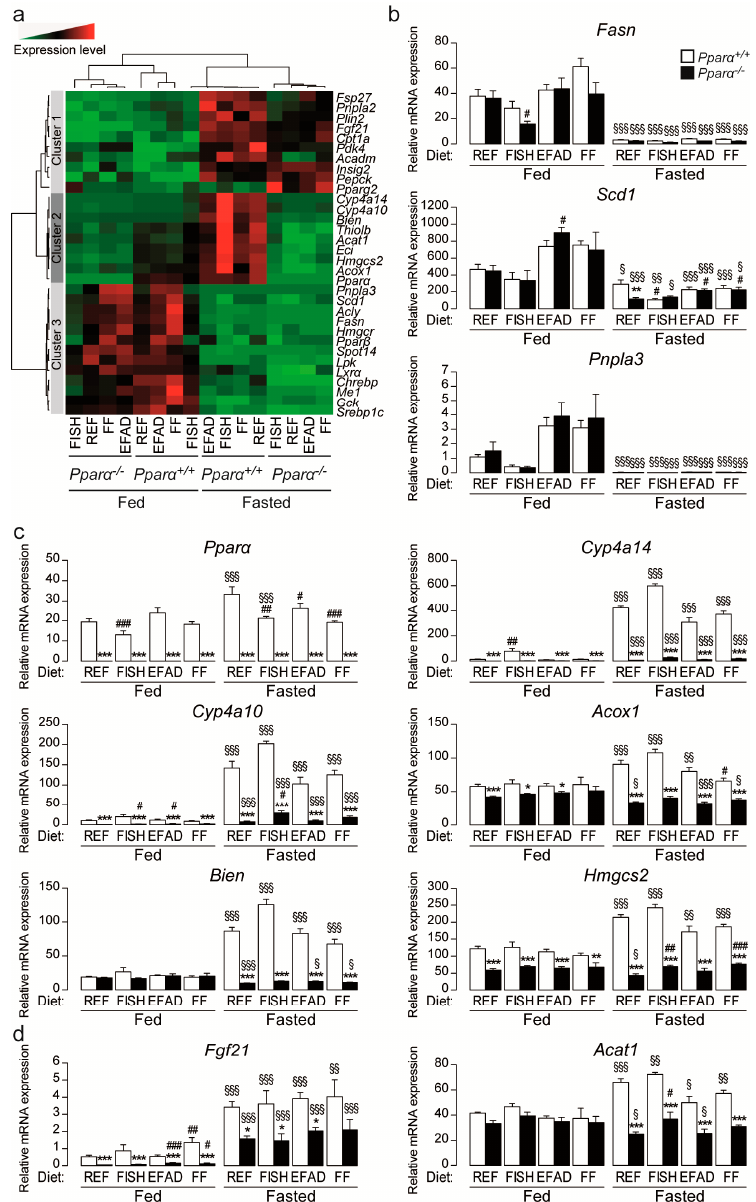
Figure 4. Effect of dietary fat on hepatic gene expression. Wild-type ( Ppar α +/+ ) and total Ppar α knockout ( Ppar α − / − ) mice were fed ad libitum or fasted for 24 h and then euthanized at ZT14. ( a ) Hierarchical clustering of hepatic gene expression data determined for 32 genes related to lipid metabolism and nuclear receptor signalling via qRT-PCR of liver samples from male Ppar α +/+ and Ppar α − / − mice; ( b – d ) Quantification of Fasn , Scd1 , Pnpla3 , Ppar α , Cyp4a14 , Cyp4a10 , Acox1 , Bien , Hmgcs2 , Fgf21 , Acat1 mRNA expression levels in the liver as determined by qRT-PCR. Data were normalized to the expression of TATA-binding protein (TBP). Data represent mean ± SEM. * significant genotype effect, # significant effect of diet composition, § significant effect of fasting. *, # , § p ≤ 0.05. **, ## , §§ p ≤ 0.01. ***, ### , §§§ p ≤ 0.001. REF: standard diet; FISH: diet enriched in n-3 essential fatty acids from fish oil; EFAD: essential fatty acid-deficient diet; FF: fat-free diet.